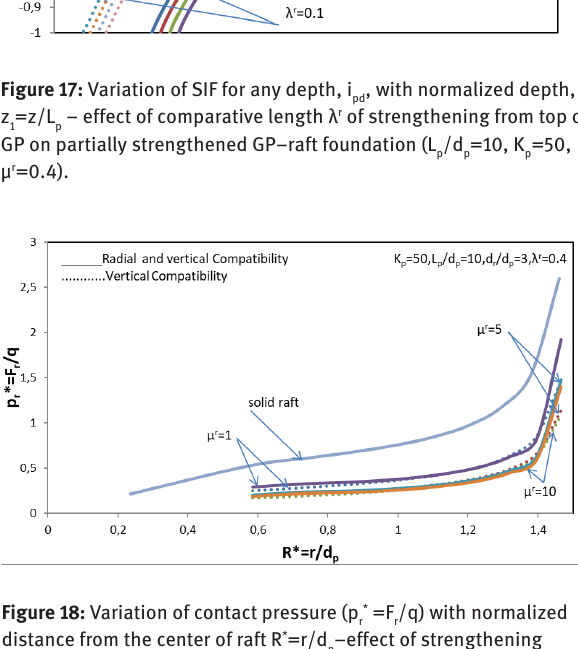
– effect of comparative length of p